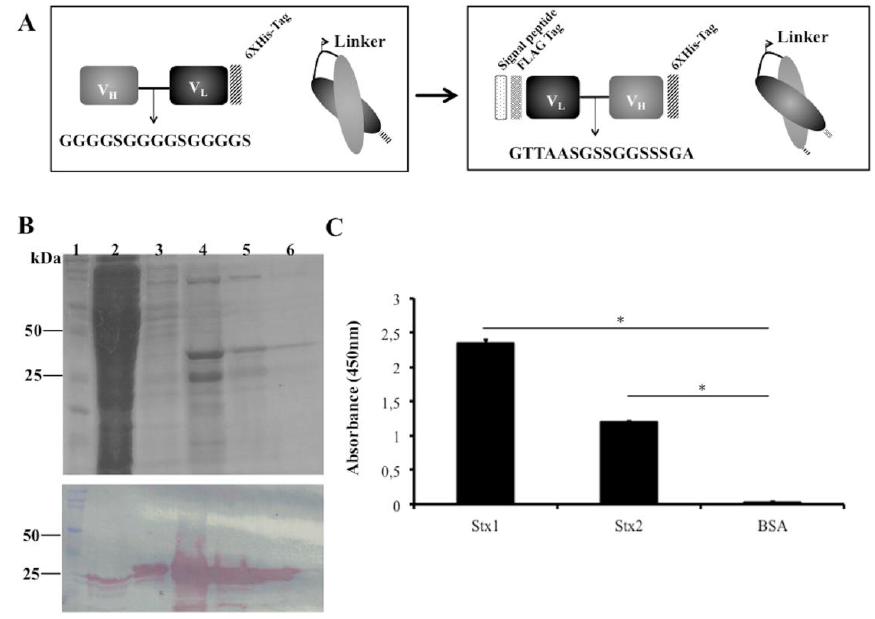
Figure 2. scFvStx1 molecule designs and purified protein. ( A ) Schematic representation of scFvStx1 assembly and modifications; ( B ) 12% SDS-PAGE analysis of scFvStx1 recombinant fragment affinity purification. Molecular marker (lane 1); flow-through fraction (lane 2); wash fraction (lane 3); elution fractions with 20 to 40 mM imidazole (lanes 4–6) showing a 25-kDa protein. Below, immunoblotting detected by peroxidase-conjugated anti-Flag antibody (1:5000), showing detection of a 25-kDa protein; ( C ) ELISA for cross-reaction employing 2 µ g of each toxin and 0.2% BSA as control. scFvStx1 was used at EC50 concentration and peroxidase-conjugated anti-Flag antibody (SIGMA) was used for detection. The assay was performed in triplicate and considered positive when p > 0.05